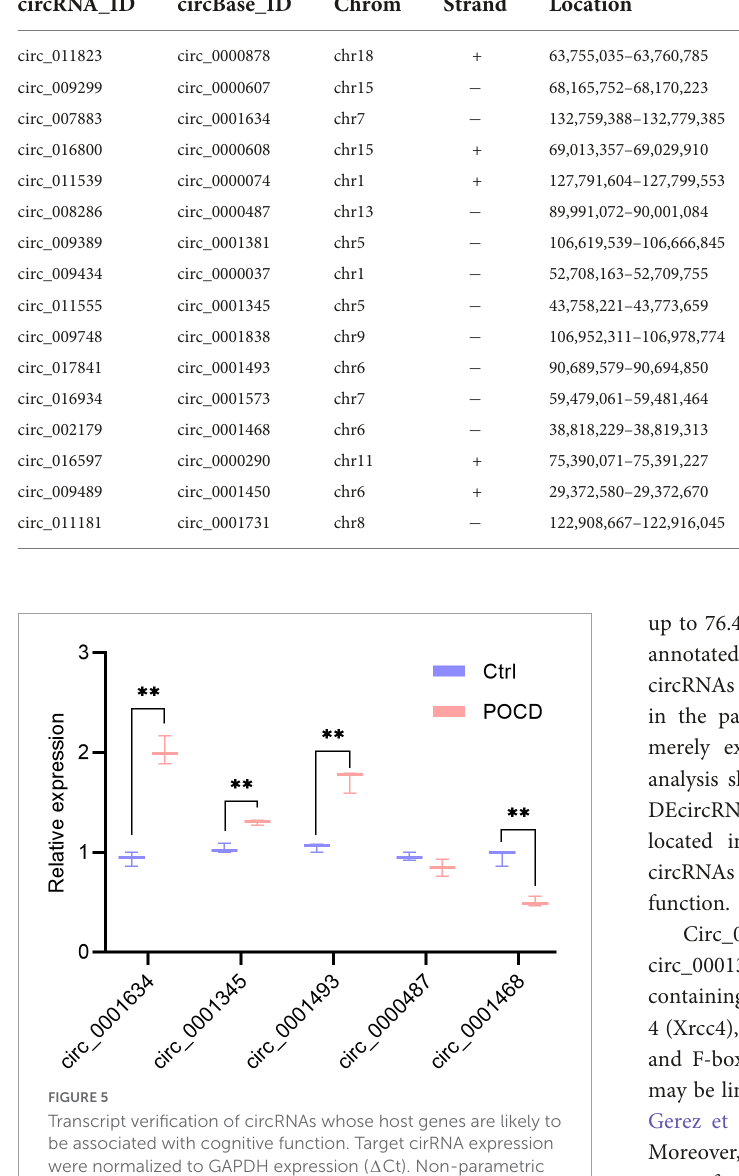
(LTP), and dendrite arborization (Narvaes and Furini, 2022). Intranuclear accumulation of β -catenin marks activation of canonical Wnt signaling that sequentially leads to enhance the transcription of Wnt target genes via the interaction between β -catenin and T-cell factor/lymphoid enhancer factor (TCF/LEF) (Narvaes and Furini, 2022). Hu et al. (2016) found that prolonged exposure to 3.6% sevoflurane could disrupt BBB components via suppressing Wnt/ β -catenin/Annexin A1 pathway in brain microvascular endothelial cells, indicating that promoting β -catenin synthesis can alleviate